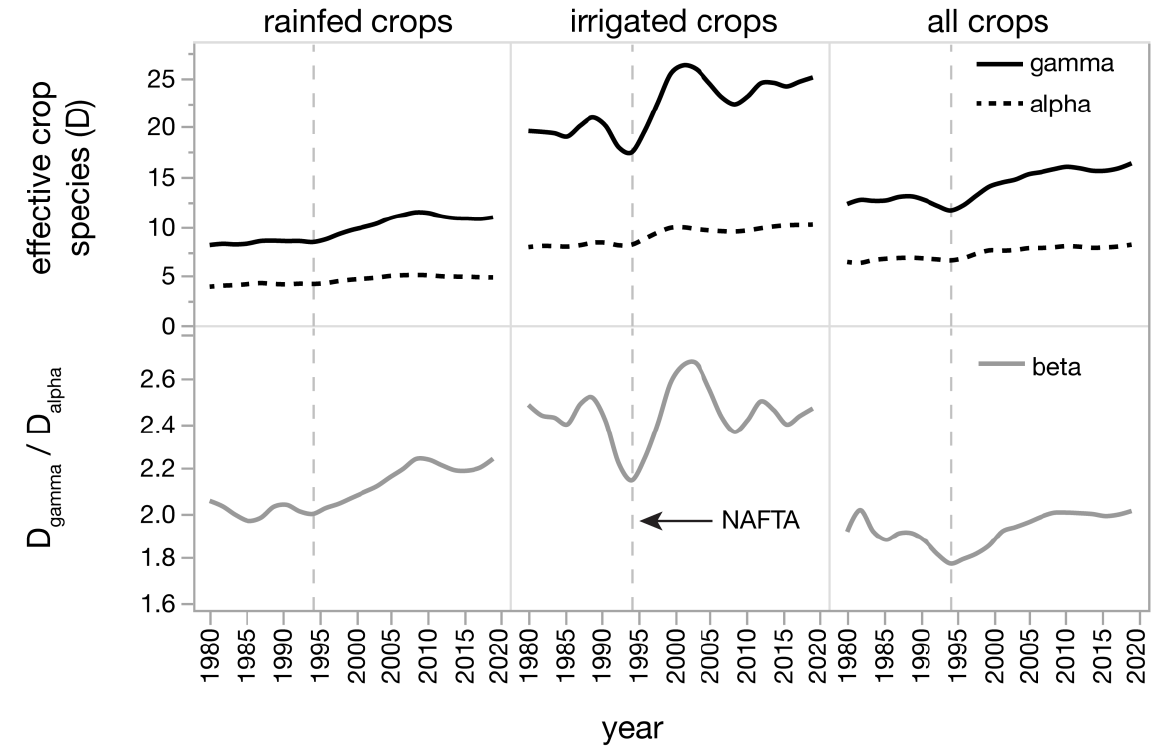
Figure 3. Changes in effective gamma, alpha, and beta diversity (D) in Mexico during the study period. Gamma diversity expresses total national-level D ; alpha diversity expresses mean state-level D ; beta diversity expresses dissimilarity in D among states.